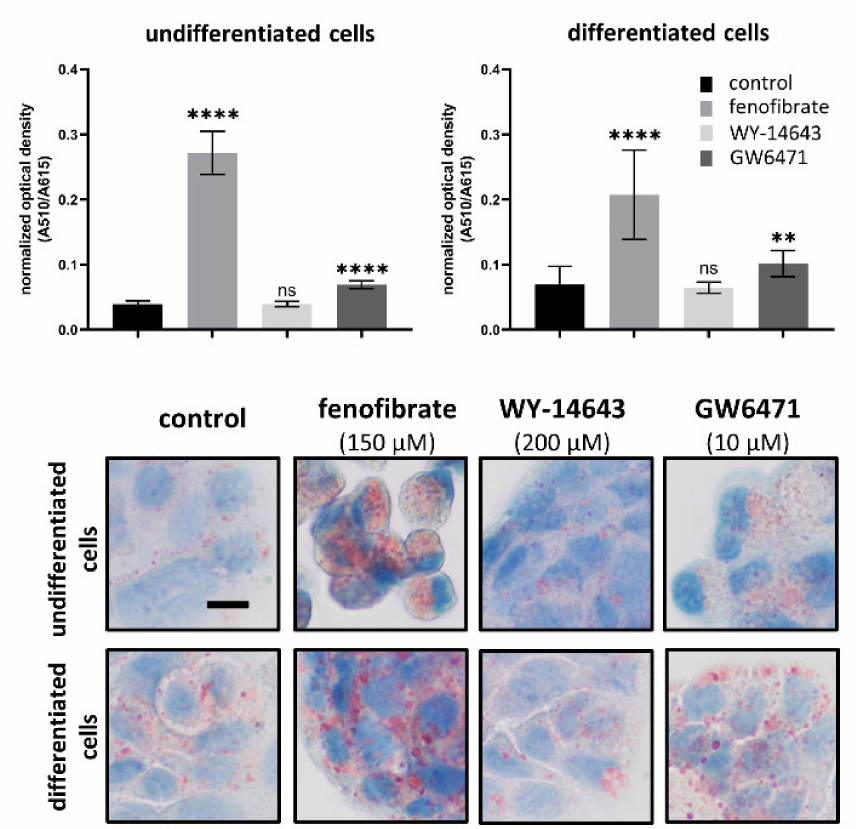
Figure 3. Lipid content in undifferentiated and differentiated HT-29 cells after treatment with PPAR α activators (fenofibrate and WY-14643) and PPAR α inhibitor (GW6471). The used concentrations were 150 µ M for fenofibrate, 200 µ M for WY-14643 and 10 µ M for GW6471. Lipid content was quantified as absorbance obtained after Oil Red O staining (A510) normalised to Janus green whole-cell staining (A615). Results are shown as the mean ± SD ( n = 12) and evaluated by the Student’s t -test. Statistically significant results in comparison to control cells are marked by ** p ≤ 0.01 and **** p ≤ 0.0001. All microphotographs are at the same magnification (400x); the black line represents 10 µ m; red - lipid droplets; nuclei